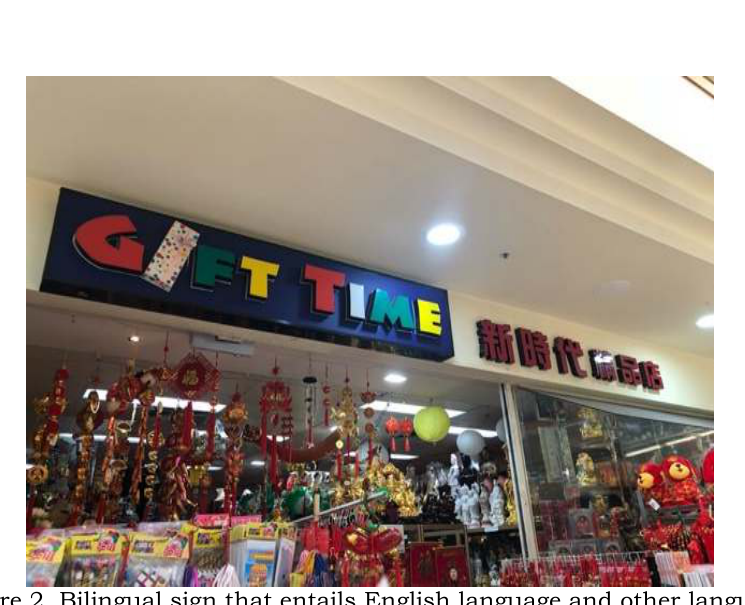
Figure 2. Bilingual sign that entails English language and other language